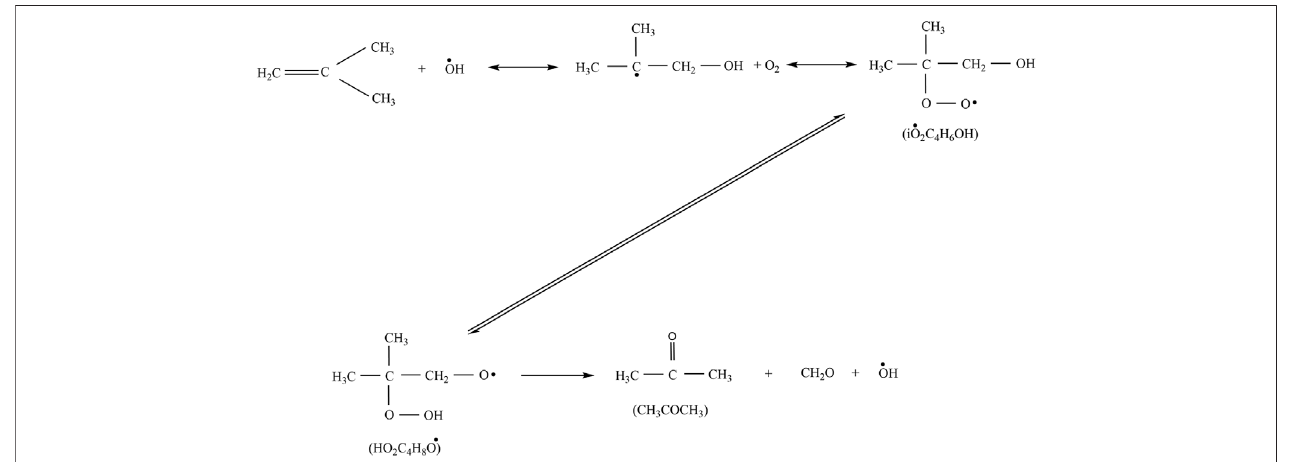
FIGURE 15 | Formation of acetone via the Waddington mechanism (Chen et al., 2000).